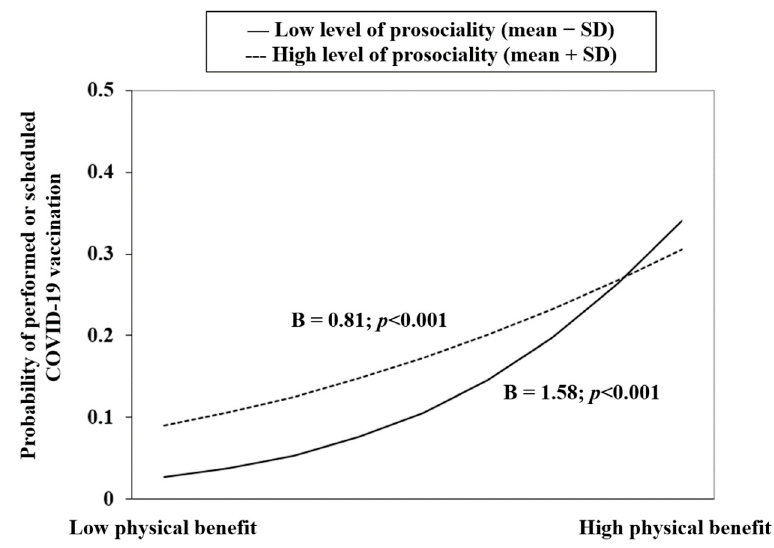
Figure 1. Prosociality moderated between physical benefit and CSFCV.